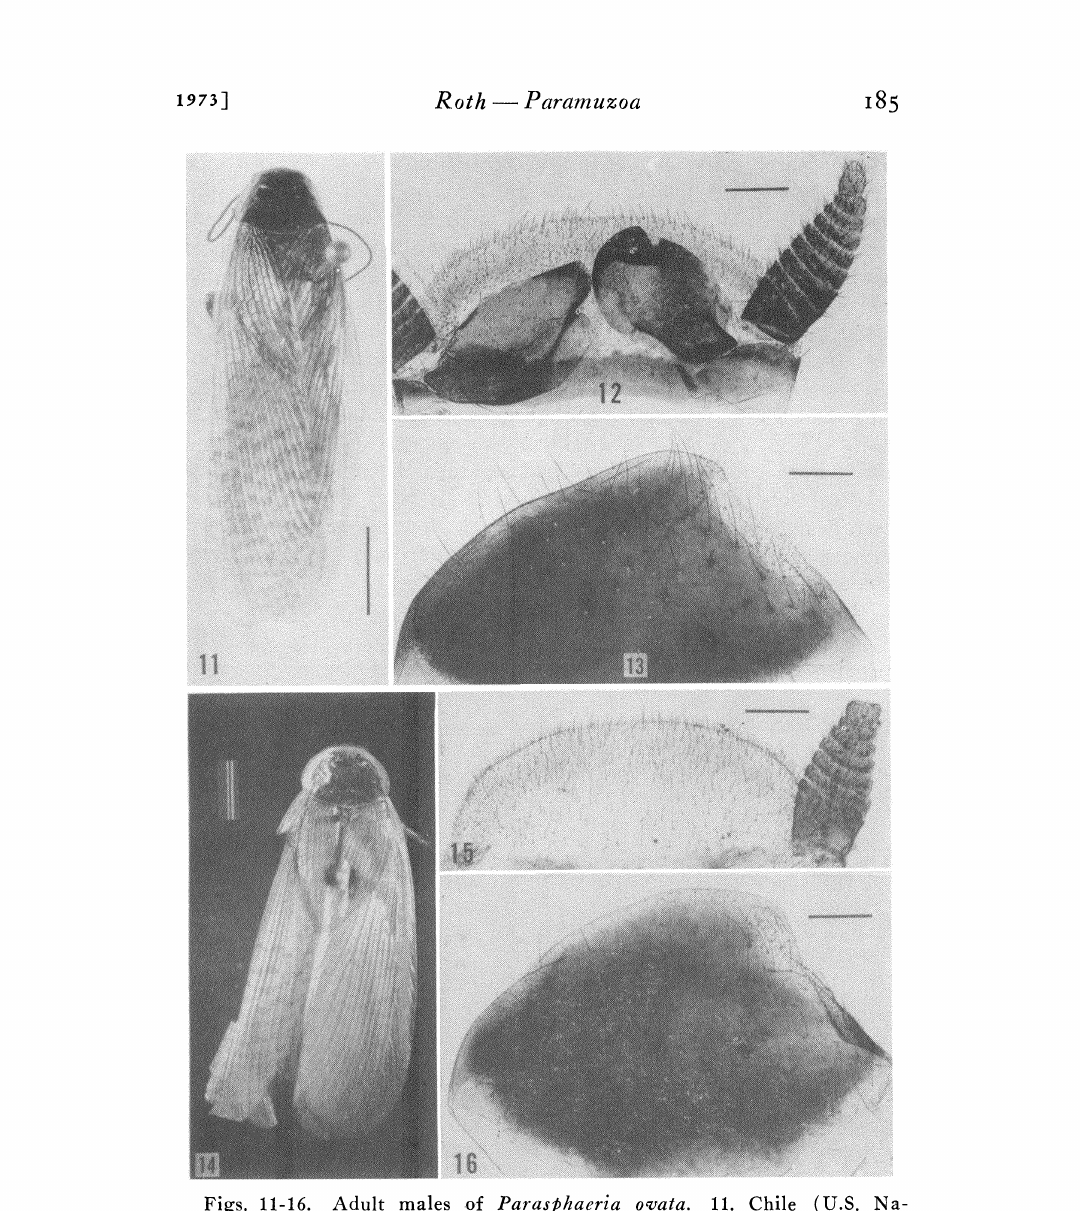
Figs. 11-16. Adult males .o.f Parasphaeria oe:ata. 11. Chile (U.S. Na- tional Museum, det. Gurney). 12. Supra-anal plate, eerci, and paraprocts (ventral). 13. Subgenital plate (ventral). (Figs. 12-13 from 8? shown in Fig. 11). Chile (Brunner’s specimen from the Natural History Museum, Vienna). 15. Supra-anal plate (dorsal). 16. Subgenital plate (ventral). (Figs. 15-16, from 8 shown in Fig. 14; scale: figs. 11, 14--5 mm, figs. 12- 13, 15-16-- 0.5